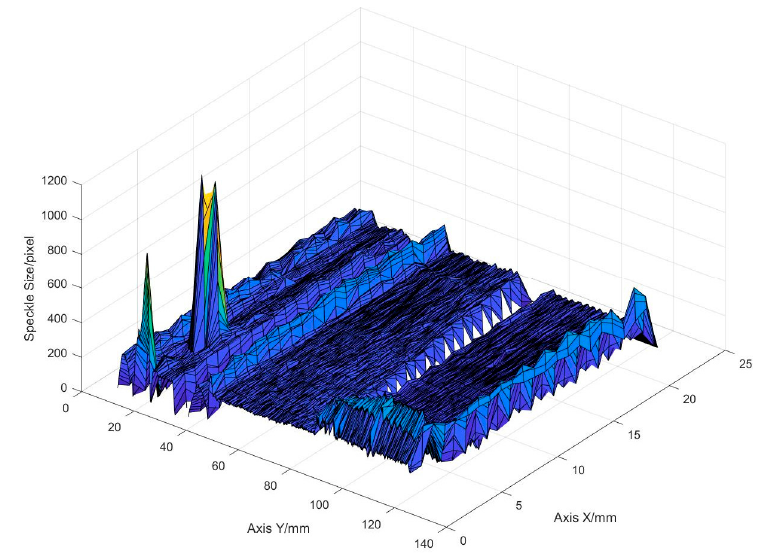
Figure 20. 2D distribution of the speckle size peaks.